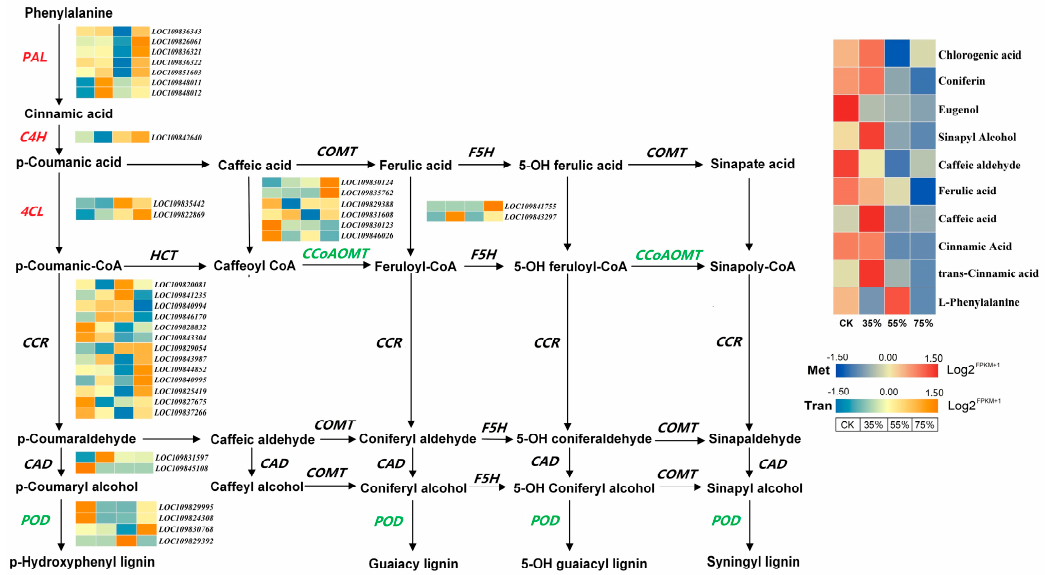
Figure 7. Heat map of lignin metabolites and gene expression of asparagus under shading treatment. Red indicates upregulation, and blue indicates downregulation. The expression decreased gradually from red to blue, and the data were calculated using FPKM.